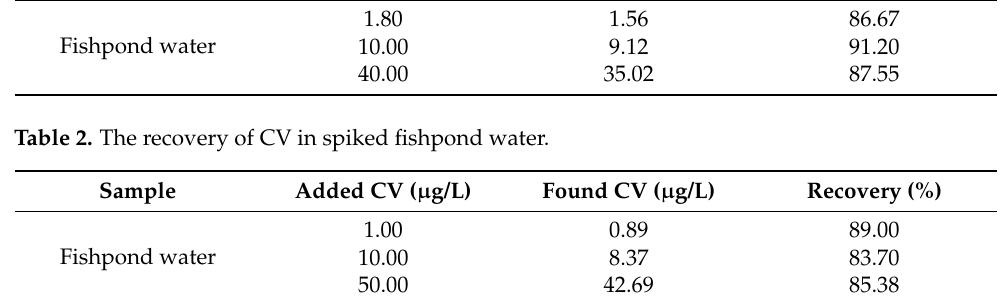
Table 1. The recovery of MG in spiked fishpond water. Sample